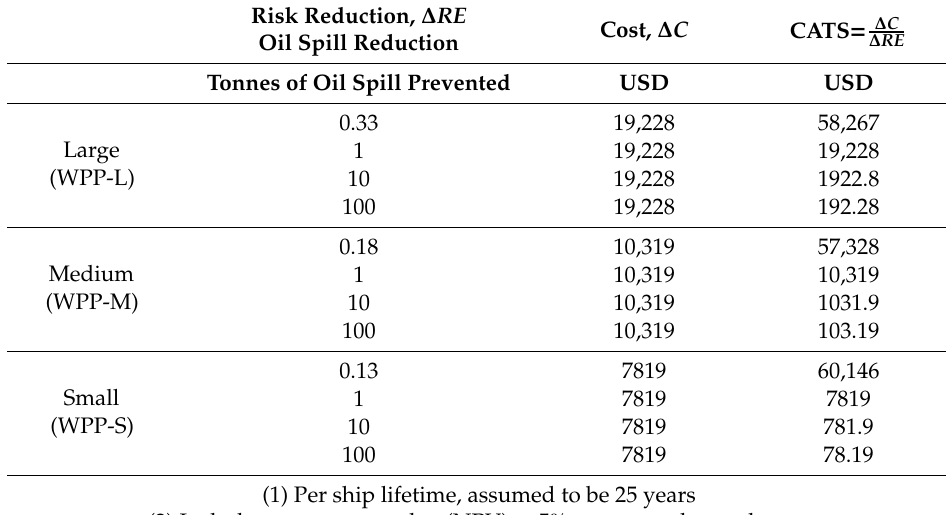
Table 10. Cost of Averting a Tonne of Spilled oil (CATS) by size of magnetic liquid stop